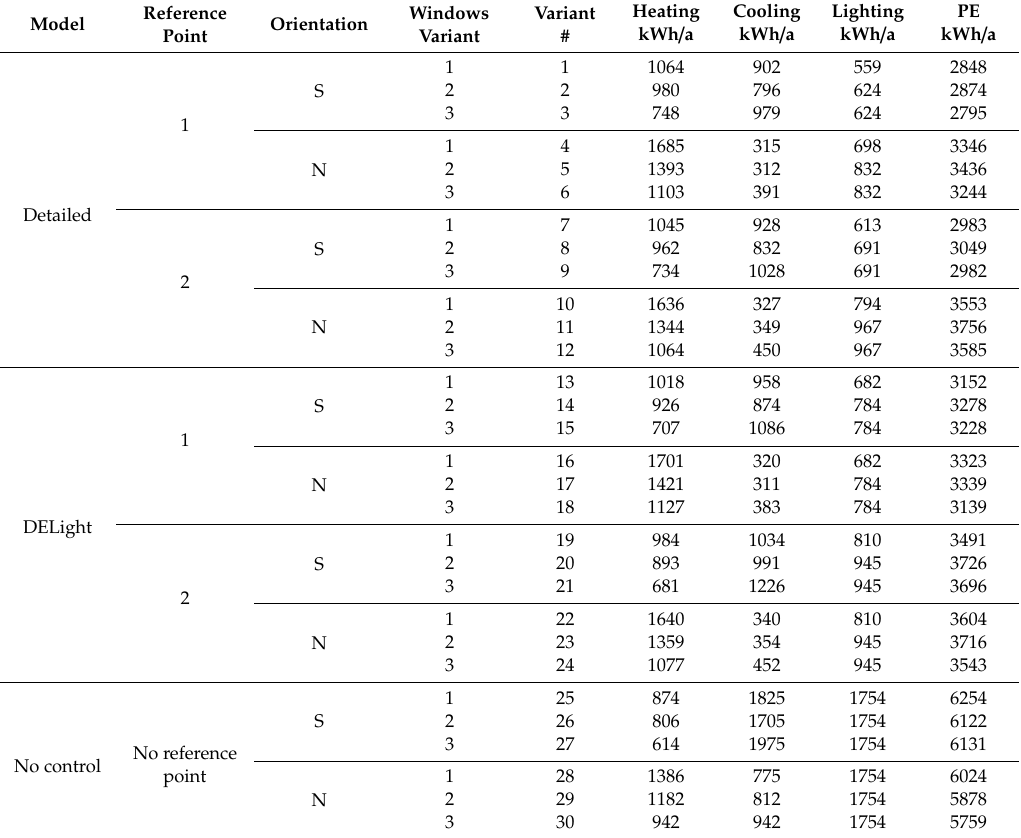
Table 4. Summary of the simulation